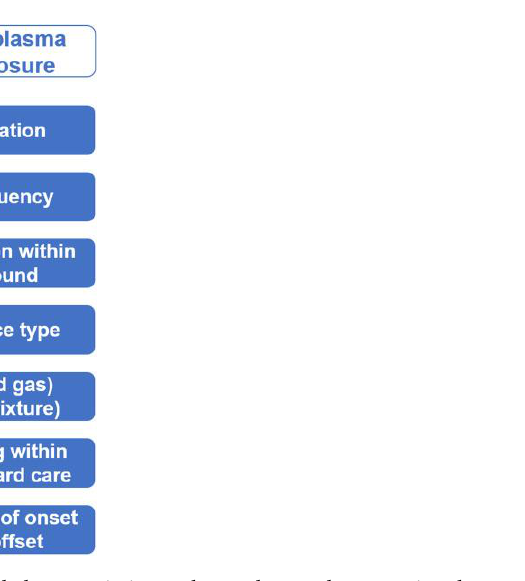
Figure 6. Processes initiated by exposure of LTP and associated wound healing [184].